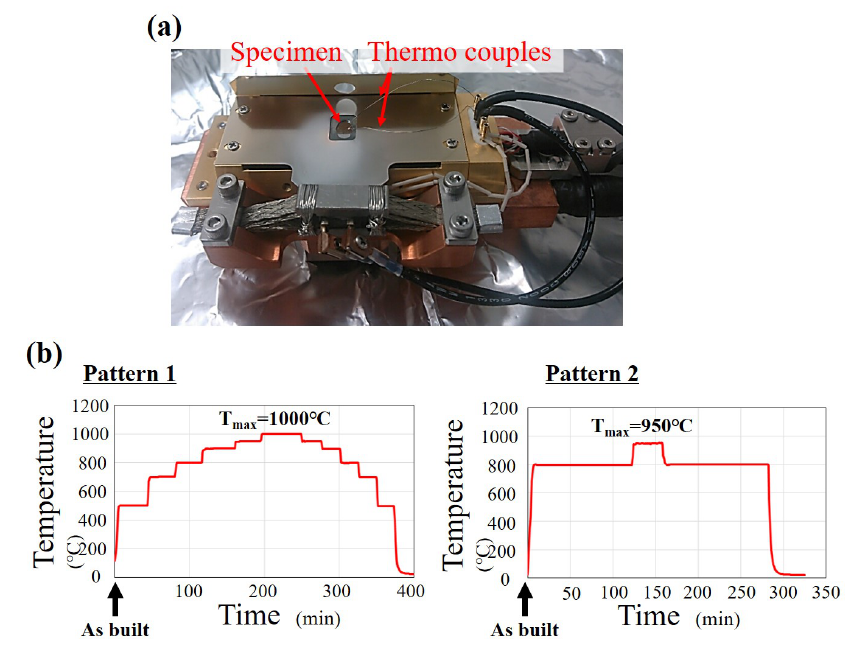
Figure 4. ( a ) Heating stage for SEM/EBSD. ( b ) Sample temperature as a function of time during SEM/EBSD